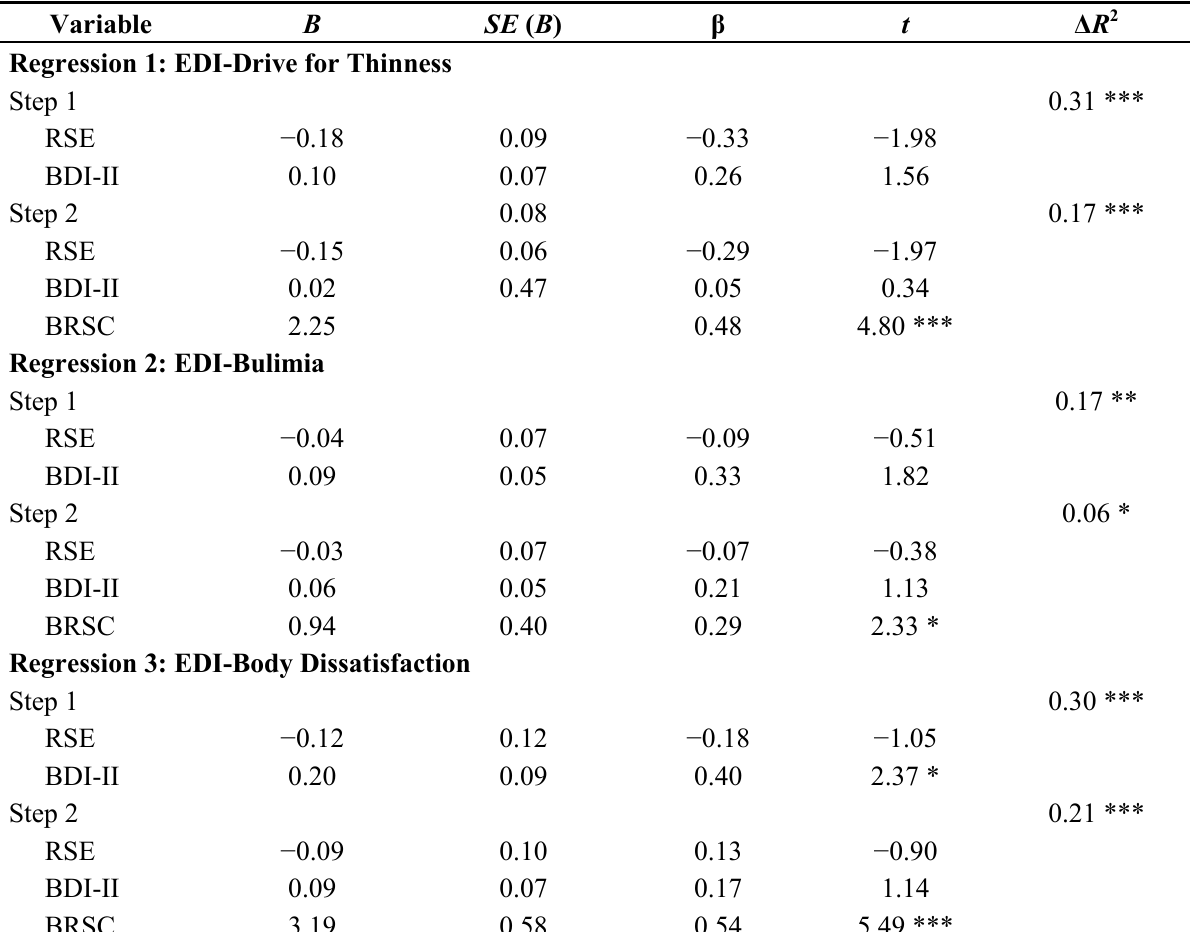
Table 3. Summary of Three Separate Hierarchical Regression Analyses for the Prediction of Scores on EDI-2